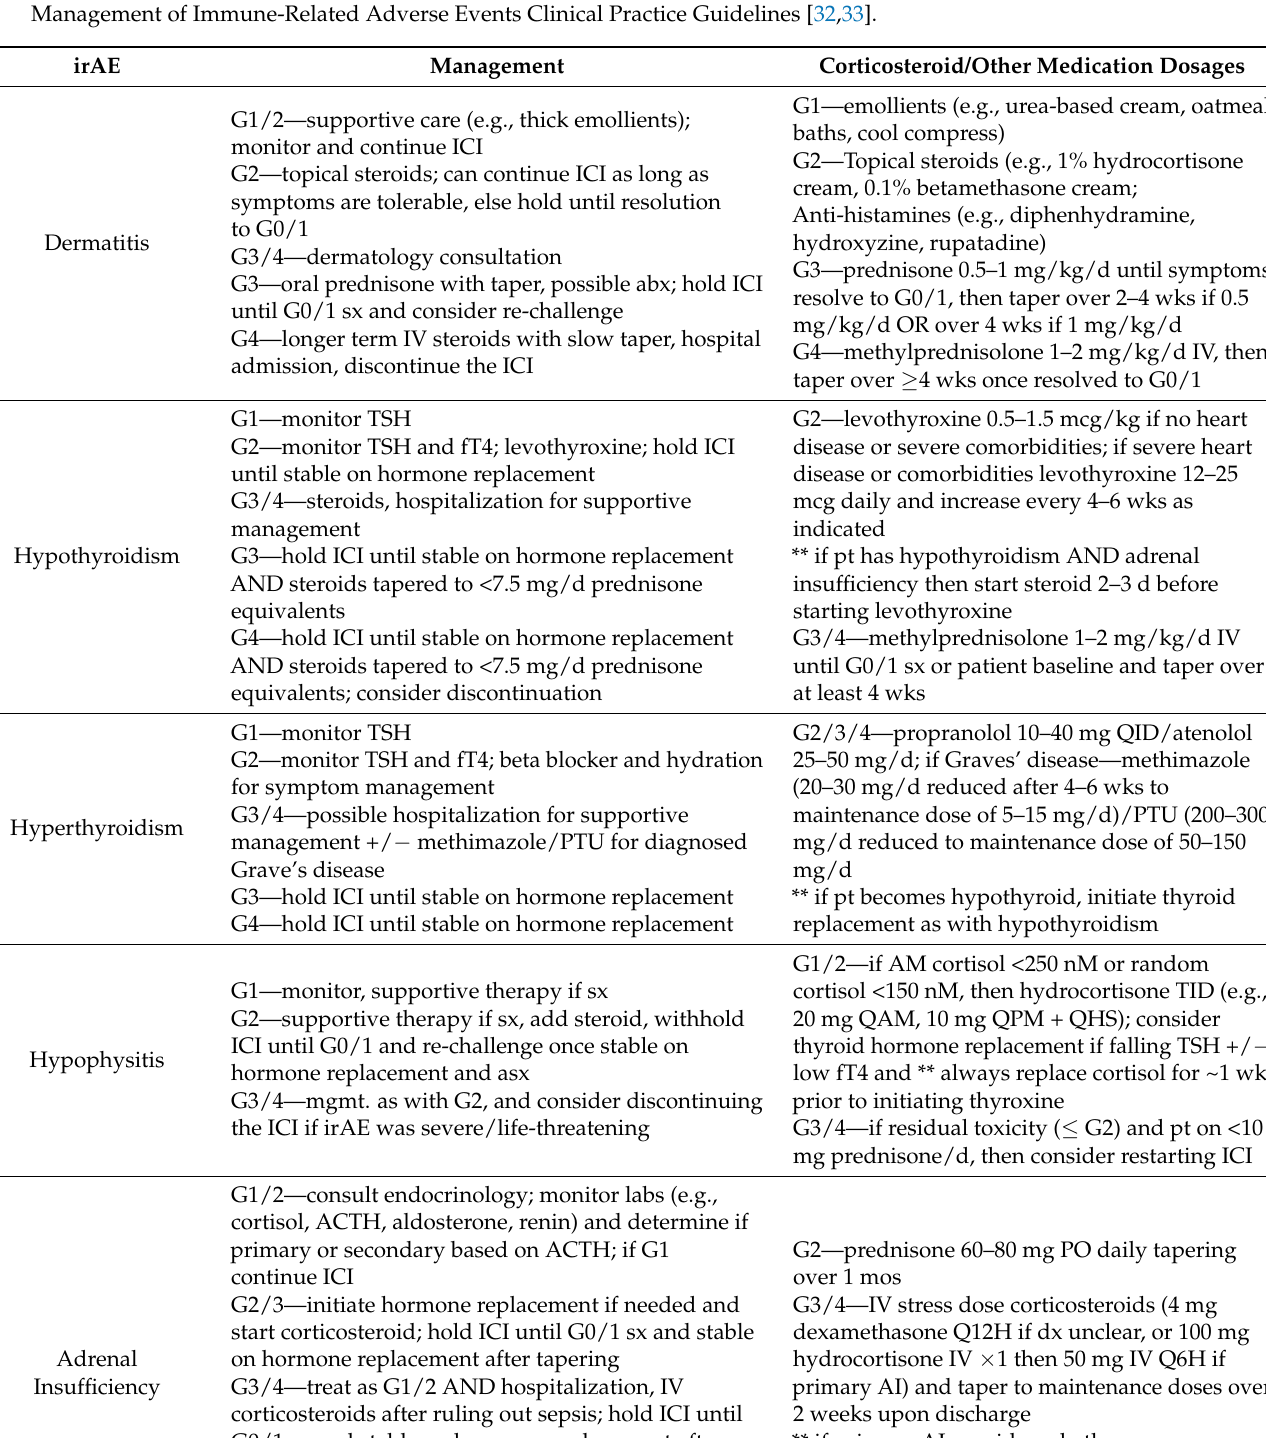
Table 1. High yield management guidelines, including steroid doses, for common irAEs. This table is an abbreviated high yield summary of the CCO Immune Checkpoint Inhibitor Management Clinical Practice Guidelines and the ASCO Management of Immune-Related Adverse Events Clinical Practice Guidelines